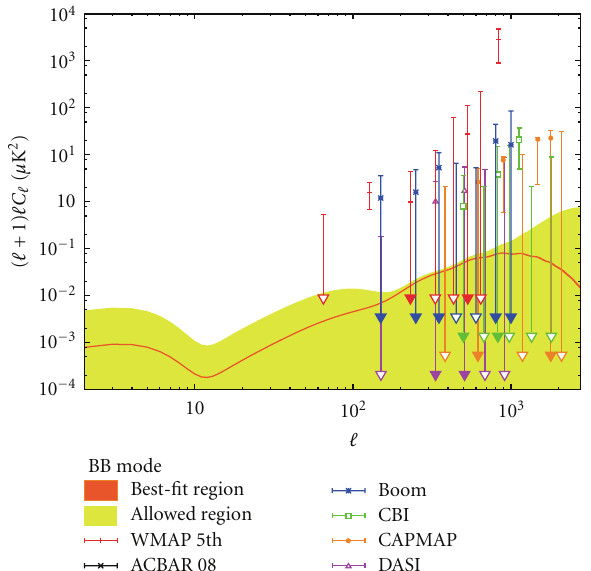
Figure 13: Comparison of the best-fit computed total power spectrum with the observed CMB spectra. The orange region is from the best-fit parameter set, and the allowed region is from the constrained parameter set as given in Table 1. Red, black, blue, green, orange, and purple dots with error bars show WMAP 5 years, ACBAR 08, Boomerang, CBI, CAPMAP, and DASI data, respectively. Downward arrows for the error bars on this figure indicate that the data points are upper limits. Since the BB mode is not a ff ected by the SZ e ff ect, the upper curves and lower curves in this figure are defined by the constrained cosmological parameters of Table